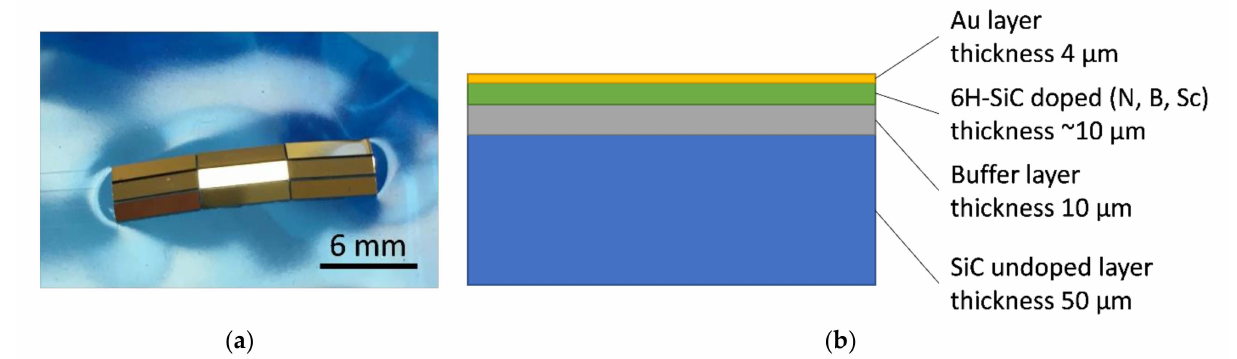
Figure 5. Multilayered SiC samples ( a ) and schematic illustration of layers on the cross-section ( b ).